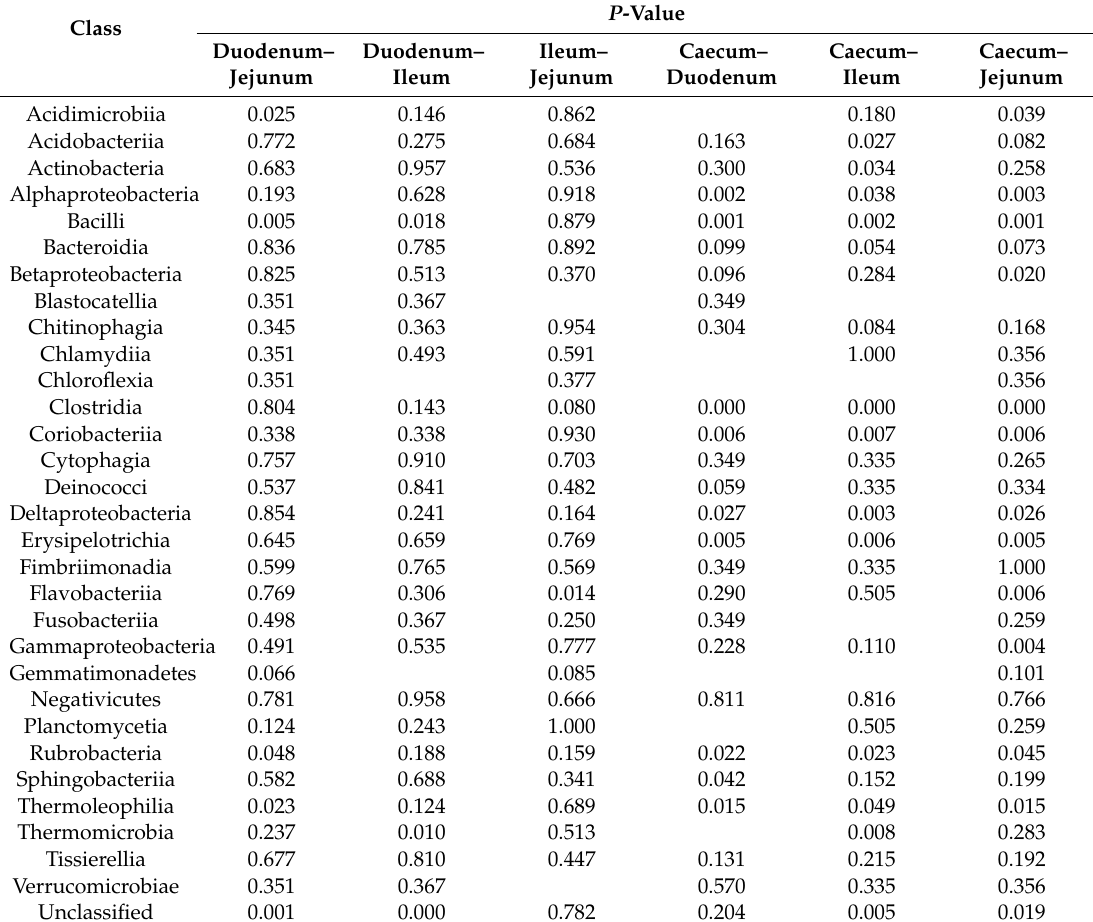
Table 5. P -value distribution of 16S rDNA gene sequence libraries compared the abundance di ff erences of microbial communities among samples from di ff erent segments for Cobb 500 Broiler